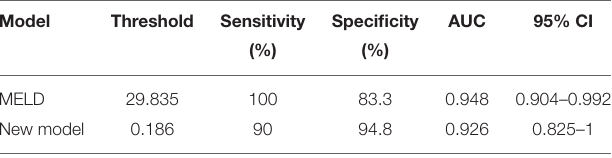
TABLE 7 | Comparison of the two models for predicting maternal